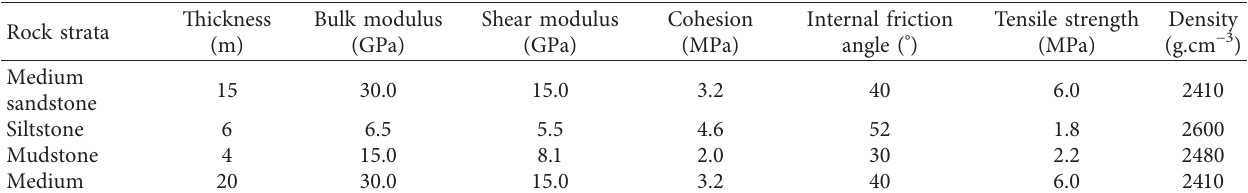
Figure 10: Schematic diagram of numerical simulation. Table 2: Mechanical properties of each rock